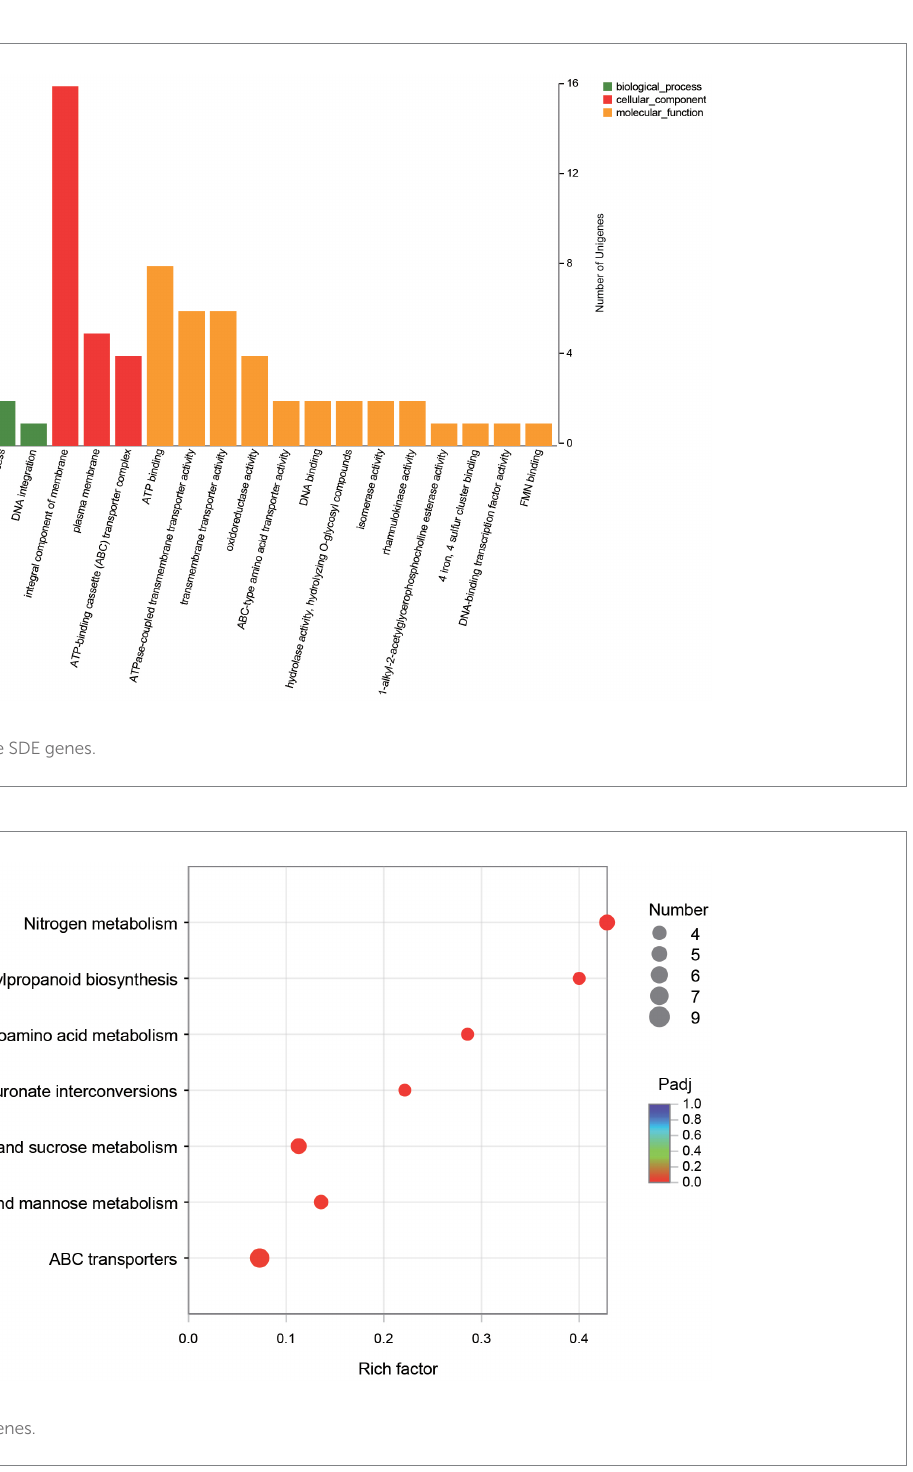
FIGURE 7 The pathway enrichment of the SDE